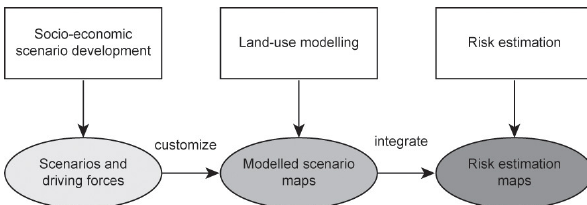
Figure 2. Simplified overview of the